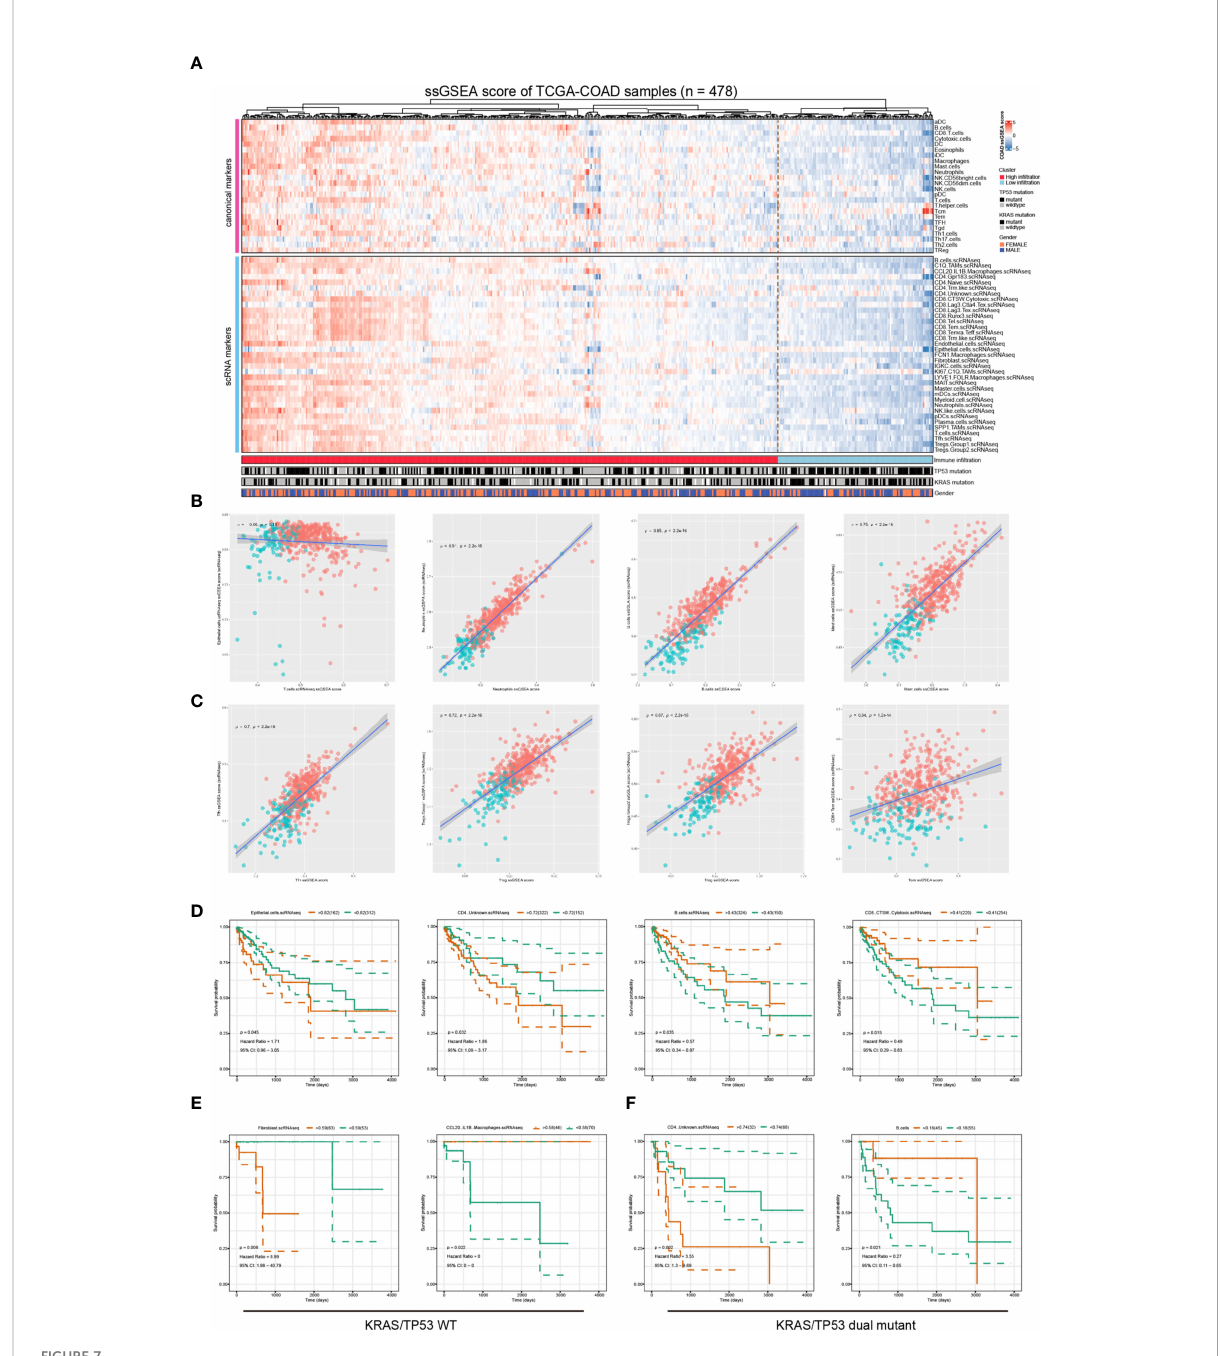
FIGURE 7 Validation the clinical relevance of the scRNA data using the TCGA-COAD dataset. (A) The Heatmap depicted the immune in fi ltration score in TCGA-COAD cohort (n = 478) based on a group of canonical immune cell markers and cell markers genes identi fi ed based on the scRNA-seq analysis. (B, C) The correlation between immune in fi ltration score determined by canonical markers and that identi fi ed using scRNA-seq identi fi ed marker genes. The spearman correlation rho- and p-value were presented in each fi gure. (D) Survival analyses showed that increased epithelial score and CD4 + unknown T cell score were associated with poorer prognosis, and increased B cell score and CD8 + CTSW + Cytotoxic T cell score were associated with a better prognosis in the TCGA-COAD cohort. The optimal separation points of the continues immune in fi ltration indicators were identi fi ed using the R survminer algorithms. (E) In patients with KRAS/TP53 wildtype colorectal cancer, the fi broblast in fi ltration score predicted worse prognosis, whereas the CCL20 + IL1B + macrophages in fi ltration predicted better prognosis. (F) In patients with KRAS/TP53 dual mutant colorectal cancer, the CD4 + unknown T cell score indicated poorer prognosis, and the B-cell in fi ltration score indicated a favorable